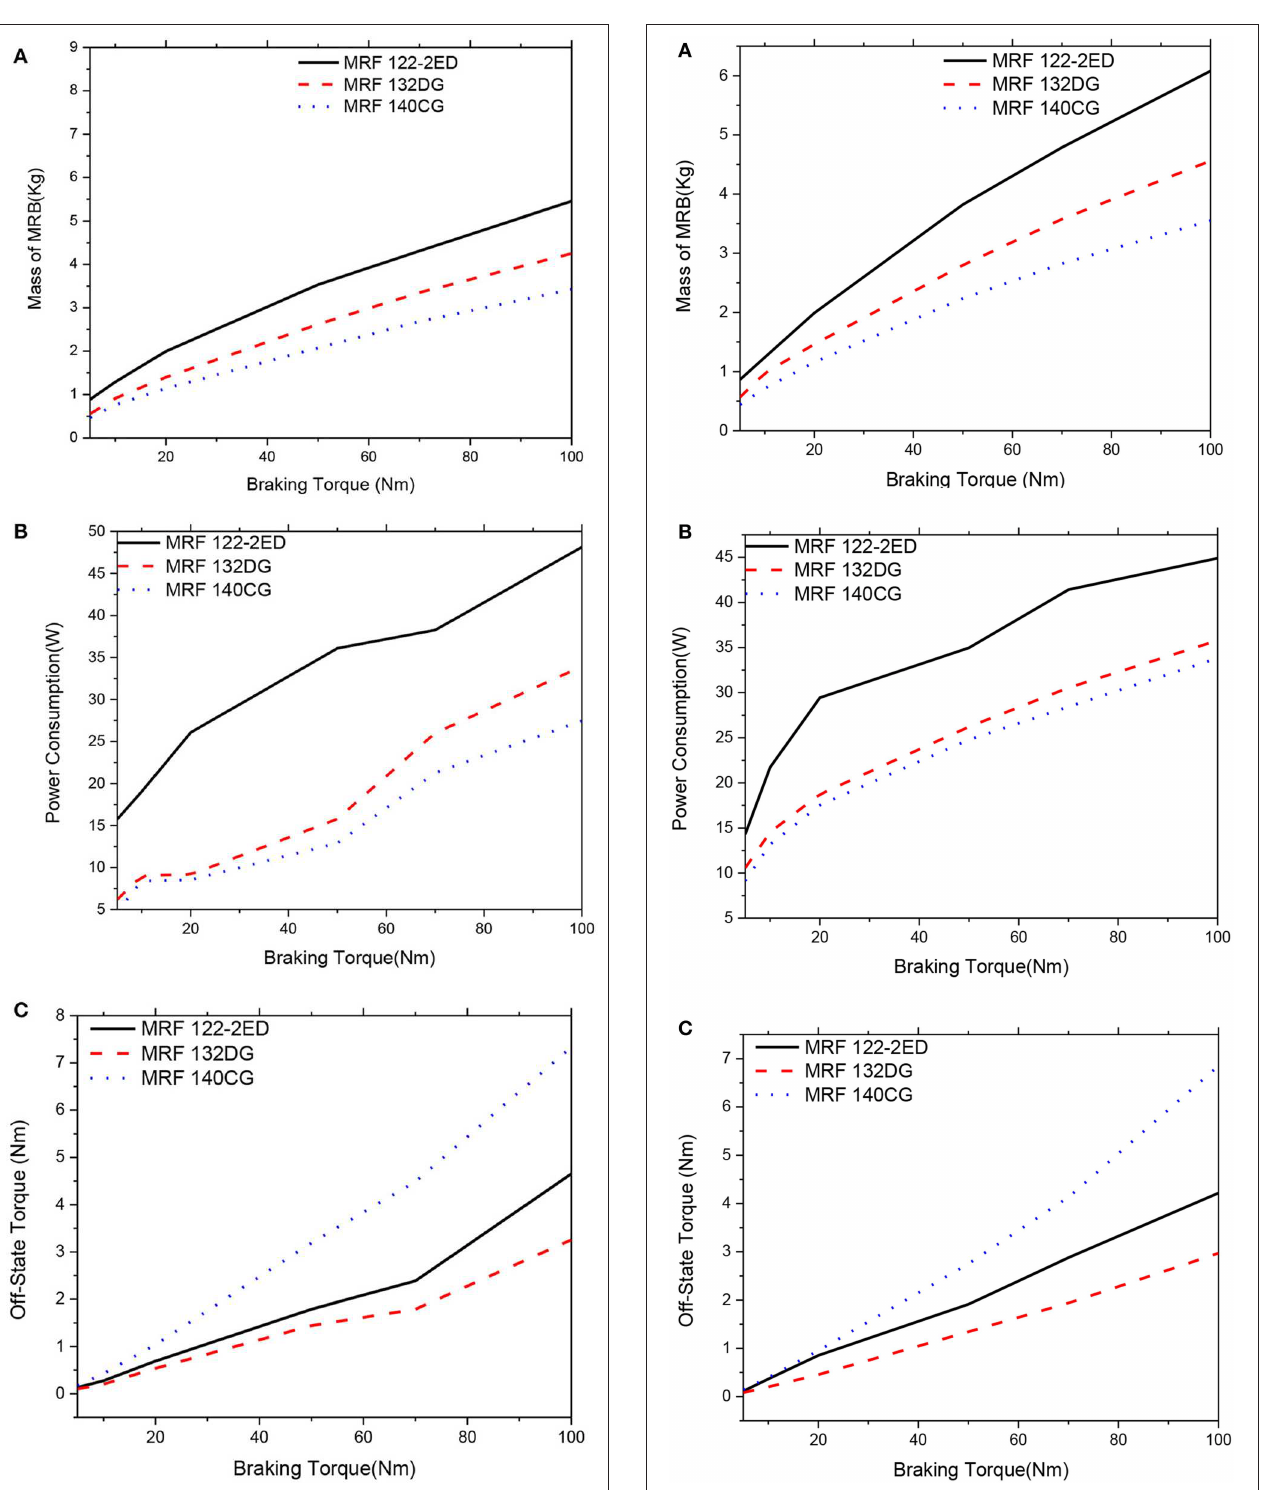
Frontiers in Materials | www.frontiersin.org